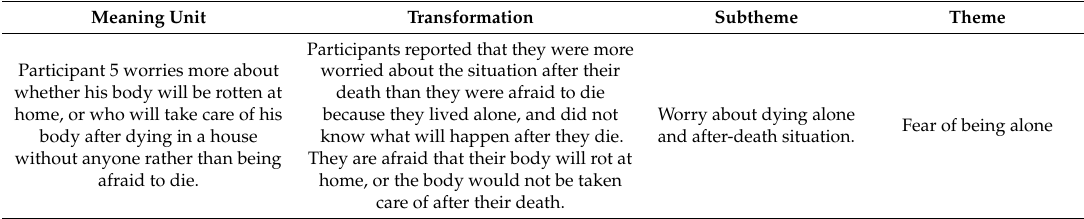
Table 2. An example of data analysis to obtain subthemes and themes. Meaning Unit Transformation Subtheme Theme Participant 5 worries more about whether his body will be rotten